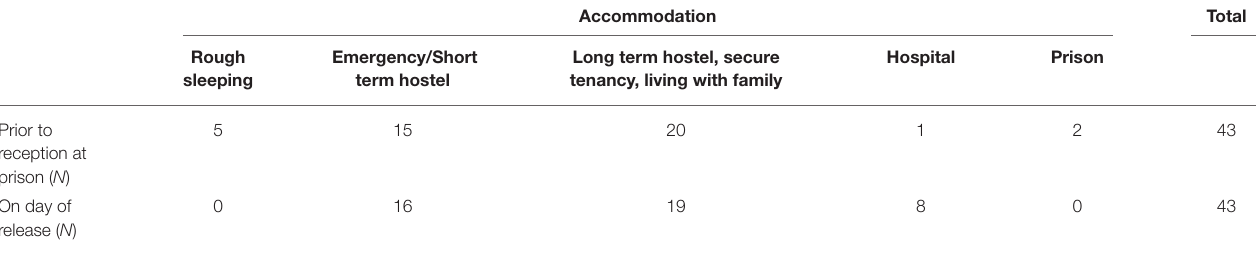
TABLE 5 | Comparison of accommodation at time of reception to prison with that on day of release, following the intervention of the PReP Programme ( N = 43). Accommodation Total Rough Emergency/Short Long term hostel, secure sleeping term hostel tenancy, living with family